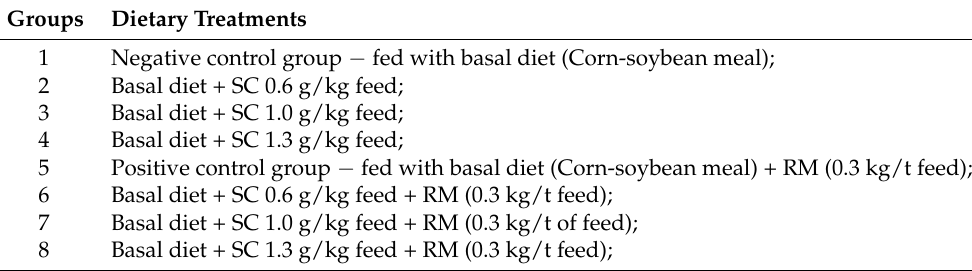
Table 1. Basal diets of broiler chicks, per each growth period 1